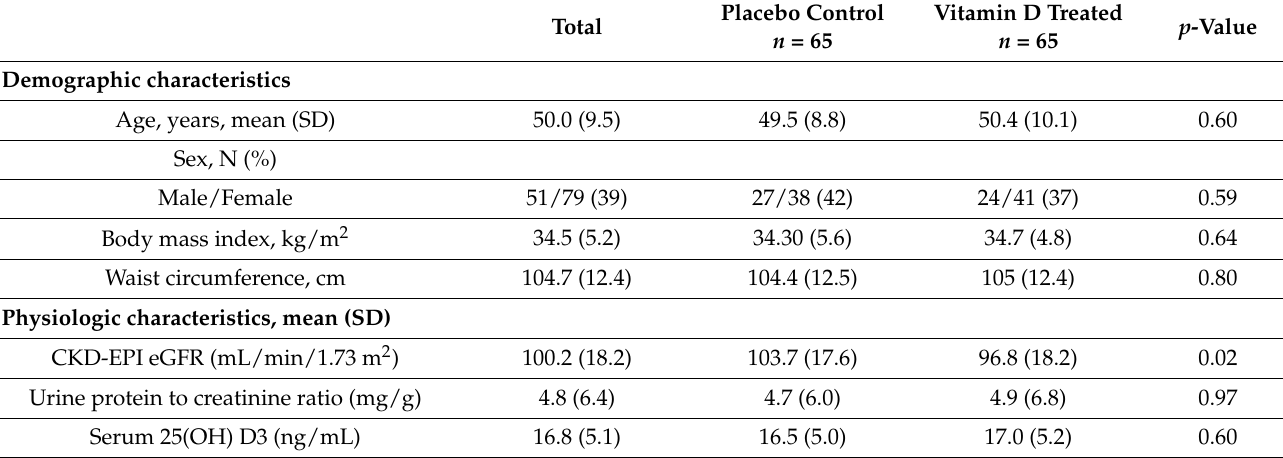
Table 1. Baseline characteristics for control and vitamin D3 treated